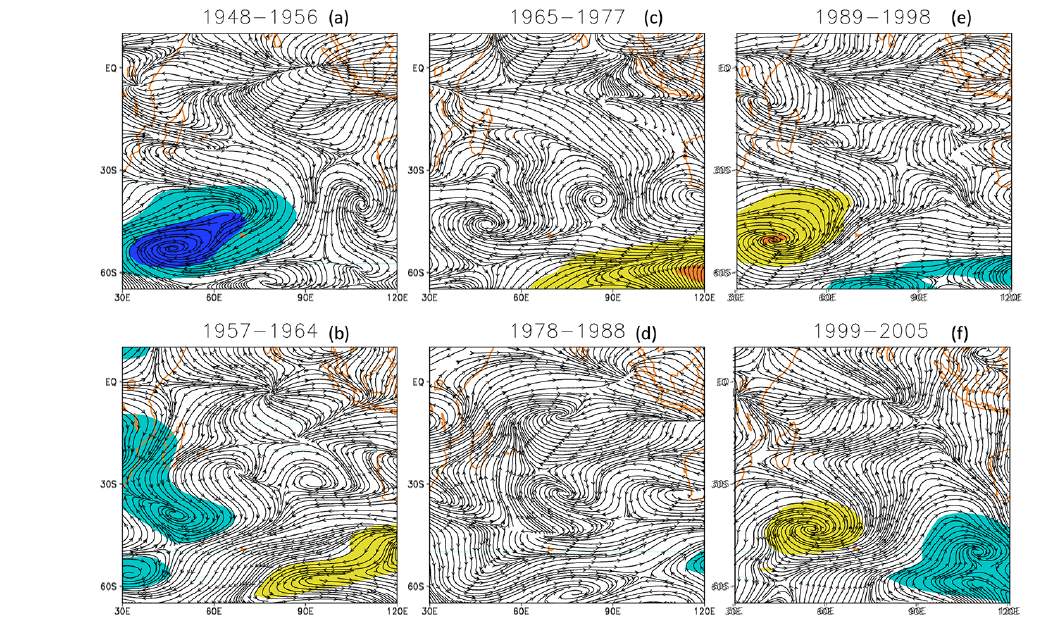
Figure 12. Indian Ocean reconstructed height (shaded) and wind field anomaly over the Indian Ocean at 1000hPa model level for the planetary wavenumbers 1–6. Shaded areas indicate the height anomaly exceeding the significant tests at the 90% confidence level (nega- tive anomaly: blue–purple shading; positive anomaly: green–yellow–red). (a) 1948–1956; (b) 1957–1964; (c) 1965–1977; (d) 1978–1988, (e) 1989–1998, (f) 1999–2005. Coastline in orange. Note the latitude range for the Indian Ocean.